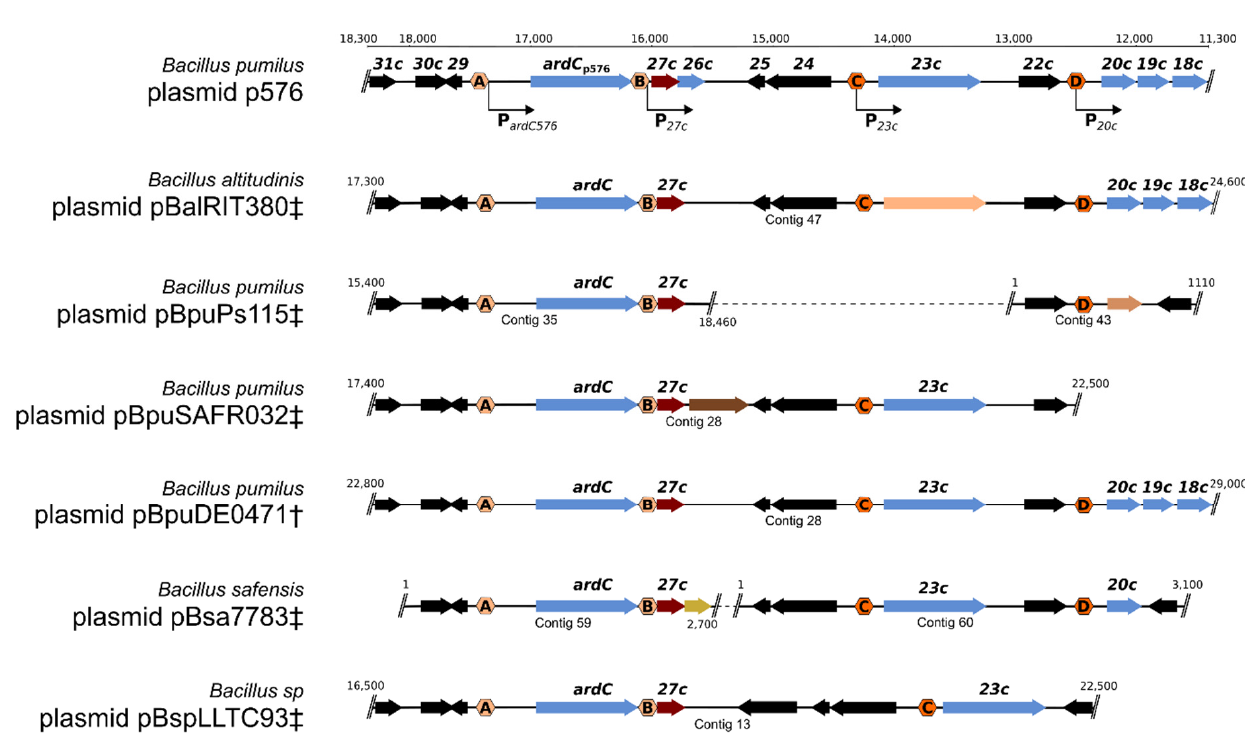
Figure 5. Putative establishment regulons present on clade II pLS20 family plasmids. Schematic view of the genetic organisation of the putative establishment regulon present on plasmid p576 and other clade II pLS20 family plasmids regulated by EGeRS2. The region shown for p576 corresponds to positions 11,300–18,400 according to accession number NZ_LR026977. Putative promoters are indicated with bent arrows. Genes are indicated with wide arrows. The positions of the repressor gene reg are indicated with red arrows. The positions of the (putative) promoters containing Reg operators (i.e., EGeRS2 regions) are indicated with hexagonal boxes labelled with a letter; orange and purple hexagonals indicate promoters flanked on one and both sides by a Reg operator, respectively. Genes controlled by EGeRS2 sequences other than reg are shown in blue, yellow, orange, or brown. Black arrows indicate genes that are not controlled by EGeRS2 sequences. Putative establishment regulons of the other clade II plasmids are approximately aligned with that of p576. The yellow, orange, and brown arrows correspond to putative establishment genes for which no homolog is present on p576. Note that p576 gene 23c is not conserved in plasmid pBalRIT380. The only two genes for which a function can be attributed are the ardC and the reg genes. Plasmids for which the entire sequence is not known are indicated with a dagger symbol. In those cases where the plasmid sequence was present in the database as one large linear contig that probably corresponds to most of the plasmid sequence, the name was extended with a single dagger. Names are extended with a double dagger symbol when the plasmid was reconstructed form two or several contigs [11].